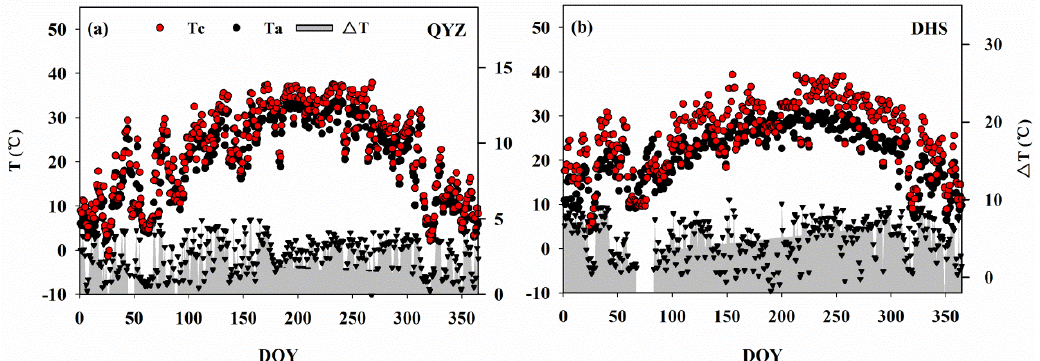
Figure 4. Mean daily variations of Tc, Ta and ∆ T at the QYZ ( a ) and DHS ( b ) sites. Tc, canopy temperature; Ta, air temperature; ∆ T, canopy-to-air temperature di ff erence. DHS, Dinghushan; QYZ, Qianyanzhou. Daily values were the 30 min mean values from 11:00 to 14:00. Table 4. Determination coe ffi cient ( R 2 ) and degree of explanation (ss%) values for factors a ff ecting the variation of ∆ T in the dry and wet seasons at the QYZ and DHS sites. Rg Ta